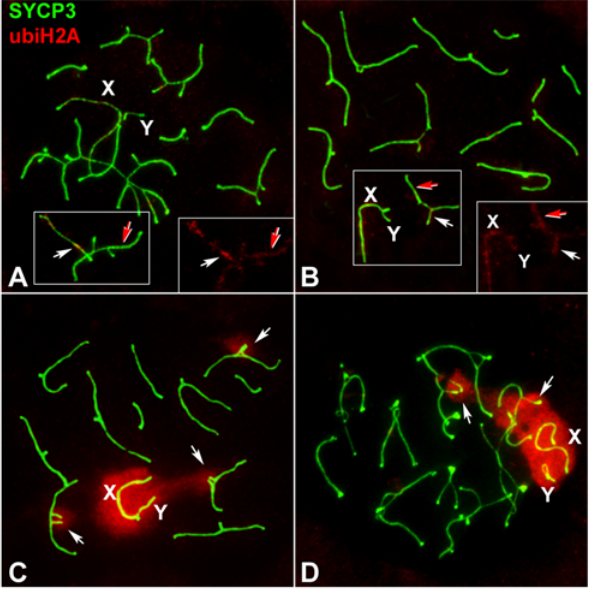
Figure 5. Localization of ubiH2A (red) and SYPC3 (green) during prophase-I. (A) Zygotene. UbiH2A is mostly absent, excepting for a weakly labeling localized along some synapsed LEs (red arrows) and unsynapsed AEs (white arrows). This labeling is only occasionally detected. Right insert represents the ubiH2A signal on the squared area. (B) Early pachytene. UbiH2A is absent although it may occasionally localize along the unsynapsed AEs of the autosomes (white arrows), the sex chromosomes (X, Y), and the synapsed LEs (red arrows). (C) Mid pachytene. UbiH2A intensely labels the chromatin of sex chromosomes (X, Y) and the chromatin surrounding unsynapsed AEs of trivalents (arrows) and is absent in the synapsed chromatin. (D) Diplotene. UbiH2A persists in the chromatin surrounding unsynapsed chromo- somes (arrows) and the sex chromosomes (X, Y) whereas it is absent in the chromatin around desynapsed segments of homologous chromo- somes.